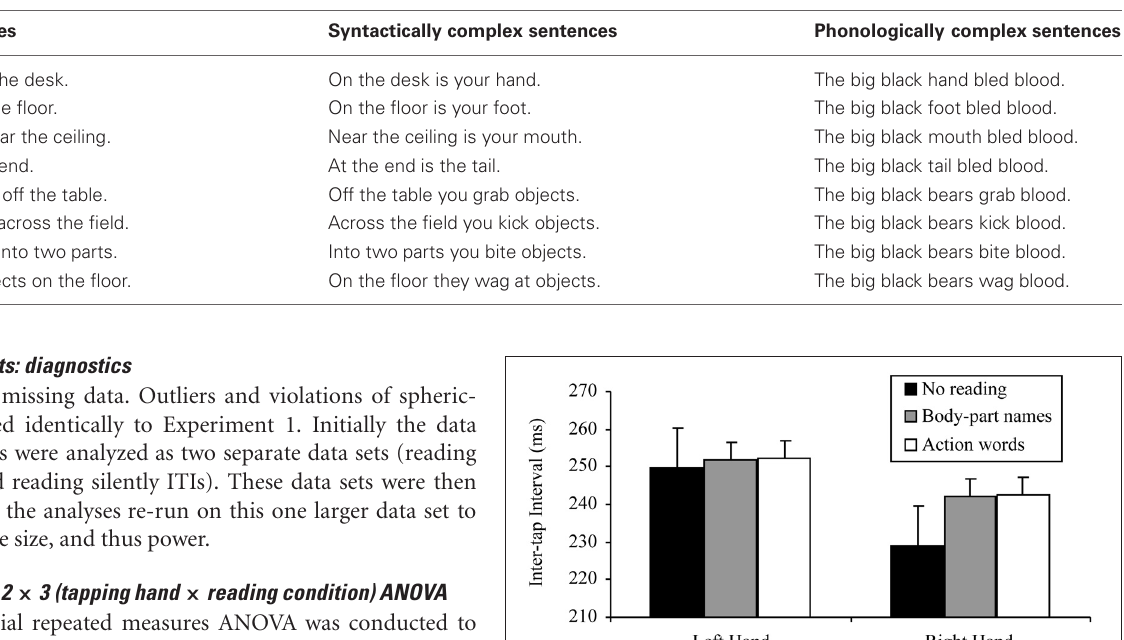
Table 1 | Sentence stimuli of Experiment 2.